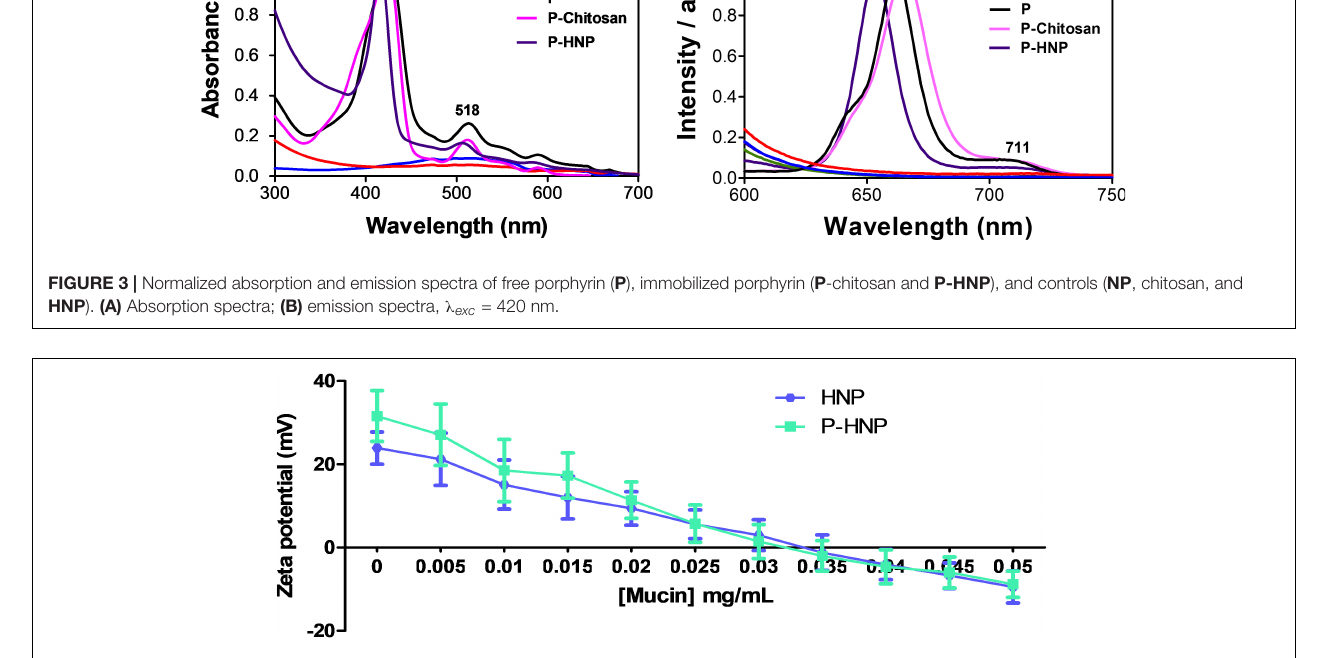
FIGURE 4 | Zeta potential values of HNP and P-HNP as function of mucin concentration in the mucoadhesion